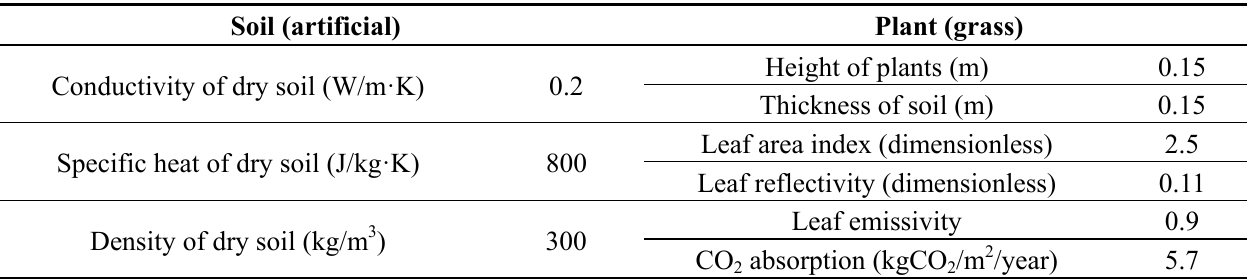
Table 2. Properties of selected green